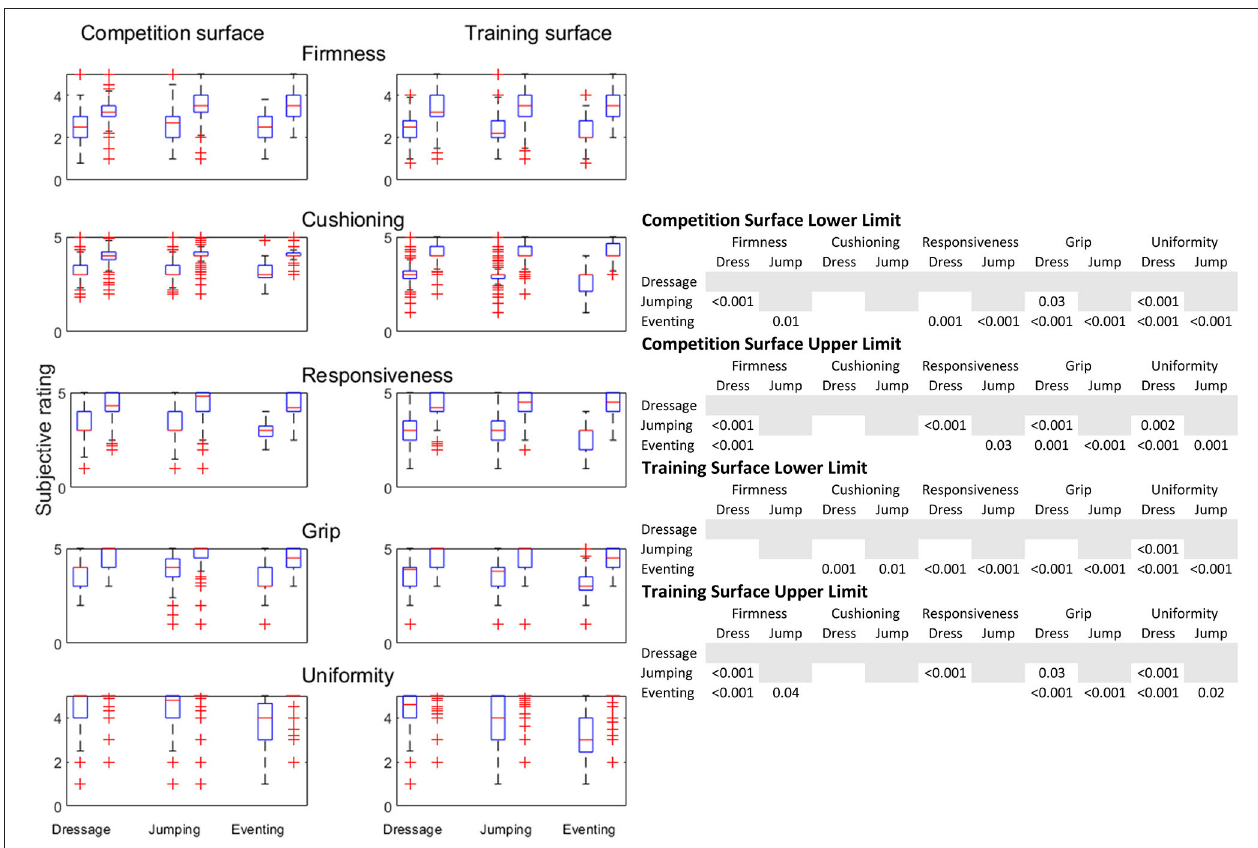
FIGURE 4 | The span of desired property values for competition and training surfaces by primary discipline. Data are from a questionnaire on riding arenas in Sweden 2014. Each pair show the desired low and high property ranges for dressage riders (between 1,024 and 1,417 answers), show-jumping riders (between 988 and 1,449 answers) and eventing riders (between 115 and 147 answers). P -values for significant comparisons between the three disciplines are shown to the right. Descriptive statistics in numbers are shown in Supplementary Material 4